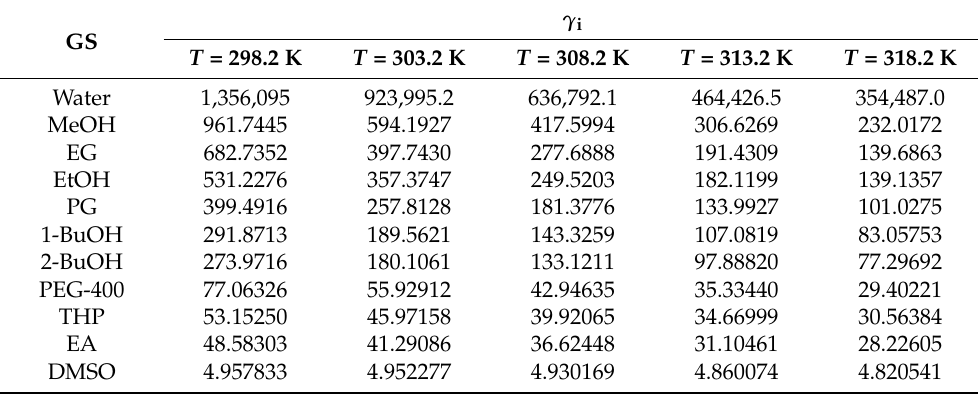
Figure 6. HSP sphere generated using HSPiP program. Table 3. Activity coefficients ( γ i ) of ITN in eleven different green solvents at 298.2–318.2 Table 2. Several solubility parameters of ITN and eleven distinct green solvents at 298.2 K.